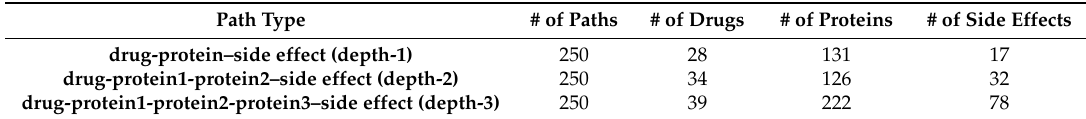
Table 3. Number of drug, protein, and SE in top 250